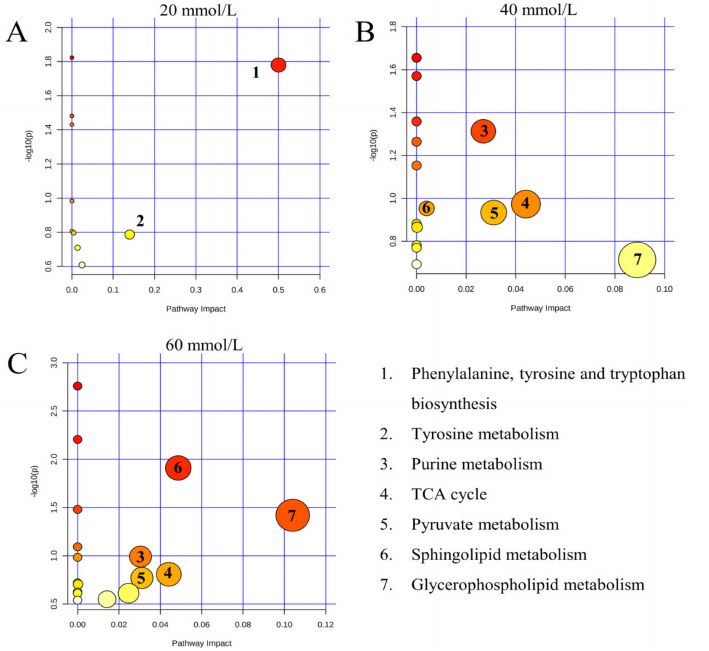
Figure 6. Metabolic pathway analysis of crucian carp kidney under different concentrations of car- bonate alkali exposure. ( A ) The metabolic pathway changes of crucian carp kidney after 20